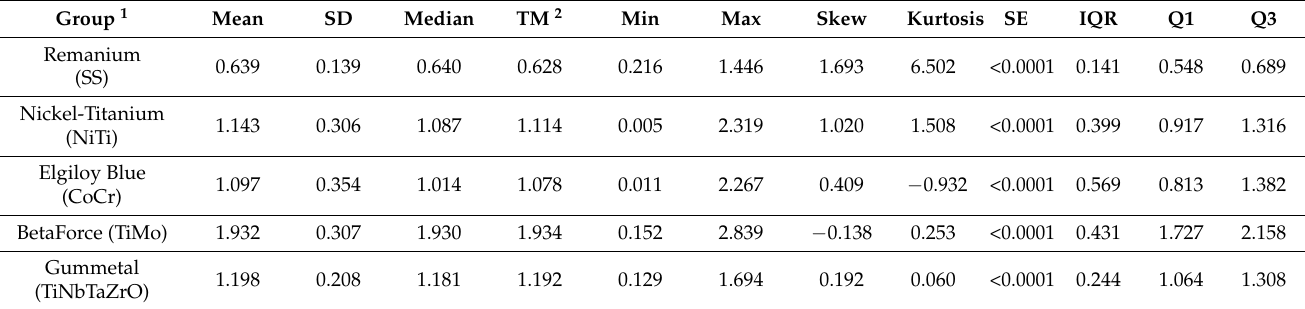
Table 1. Distribution of the kinetic FF by the groups of samples (unit;